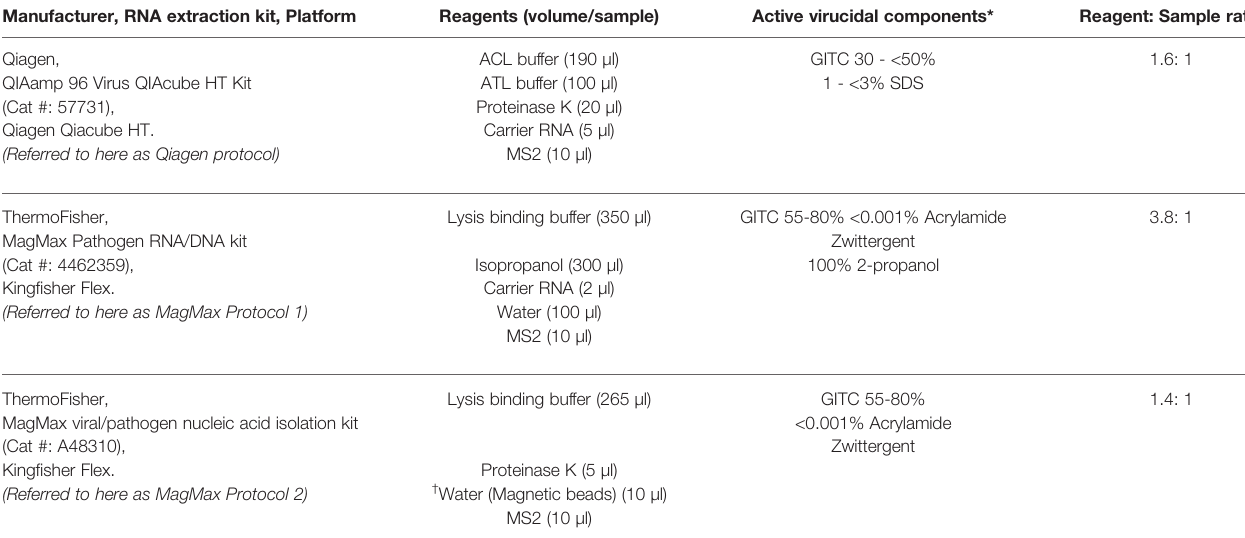
TABLE 1 | Protocols tested for assessing inactivation using lysis buffers. Manufacturer, RNA extraction kit,